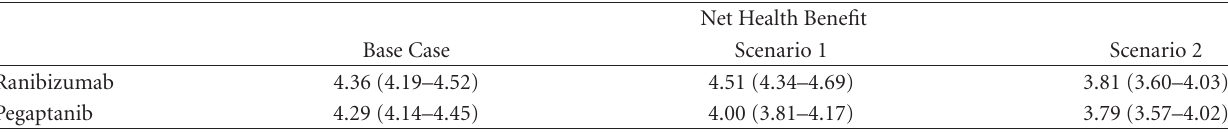
Table 4: Mean quality-adjusted life years associated with alternate intended e ff ects scenarios incorporated over the duration of the model.